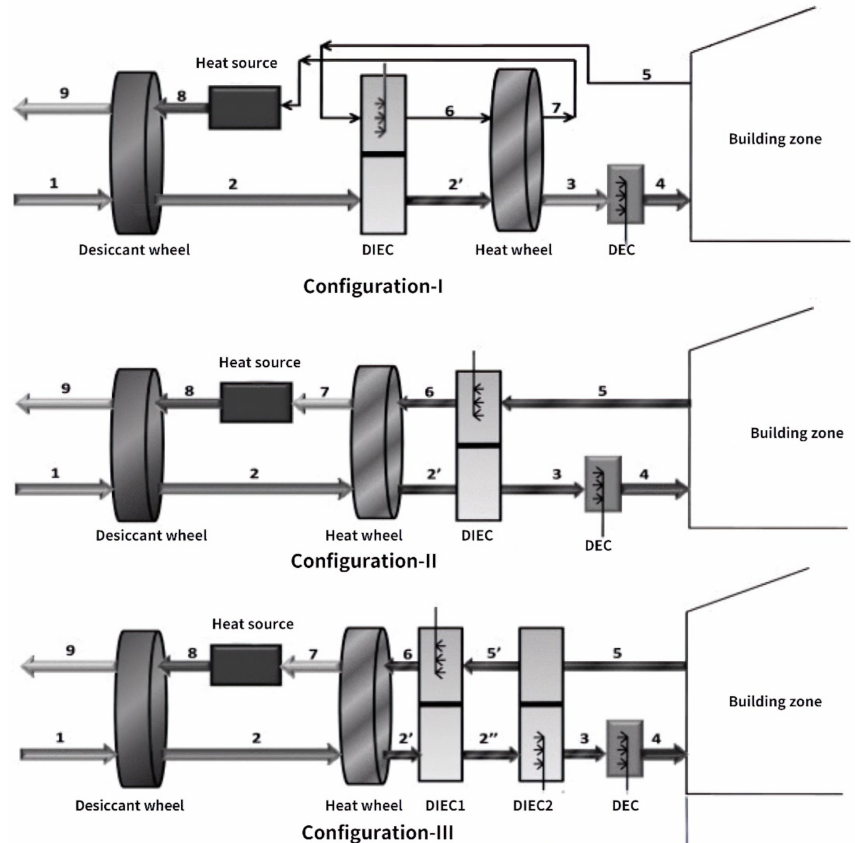
Figure 7. Three proposed desiccant evaporative cooling systems (modified from [74]).